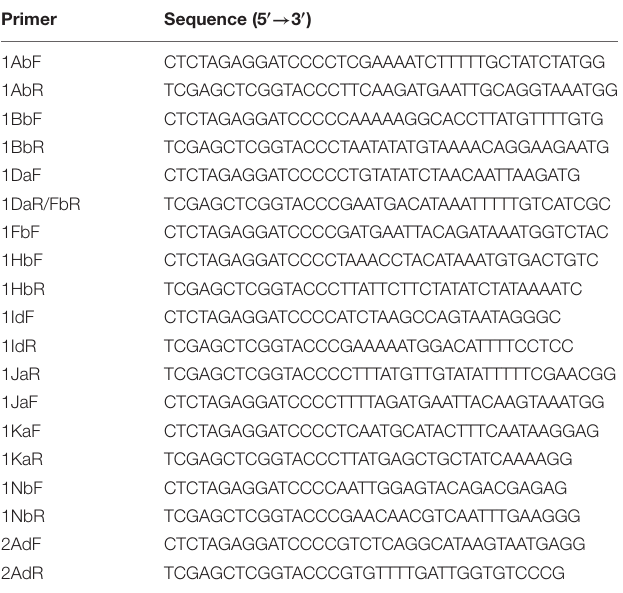
TABLE 1 | List of oligonucleotides for cloning the cry genes.